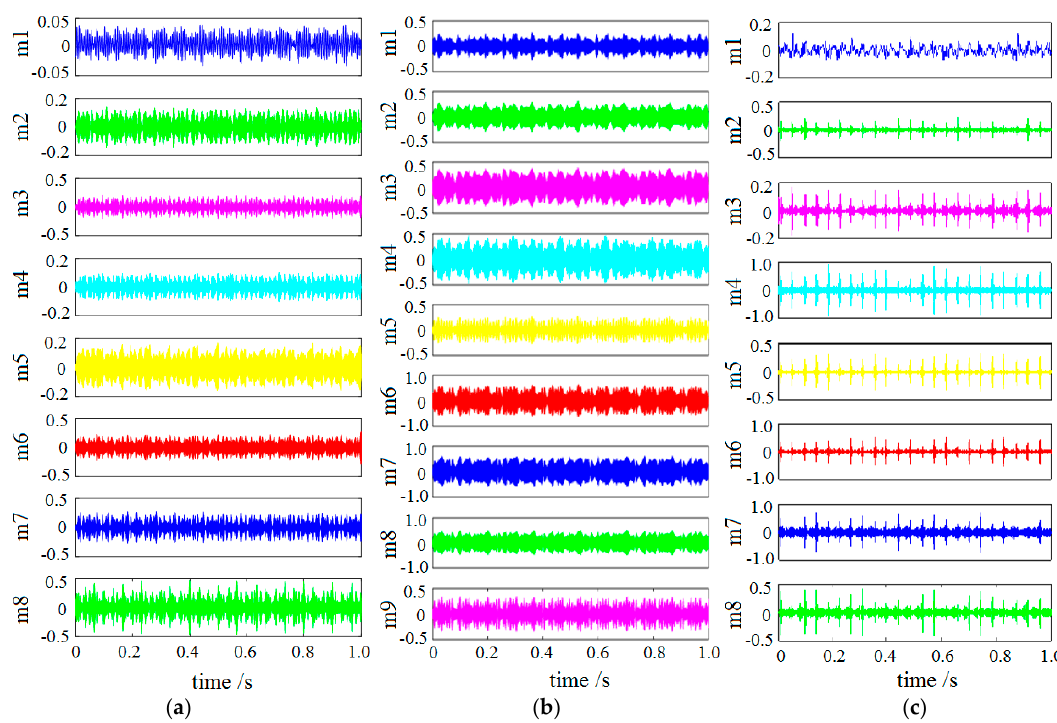
Figure 7. The signal decomposition results derived using the enhanced EWT: ( a ) inner race fault; ( b ) outer race fault; ( c ) gear tooth fault